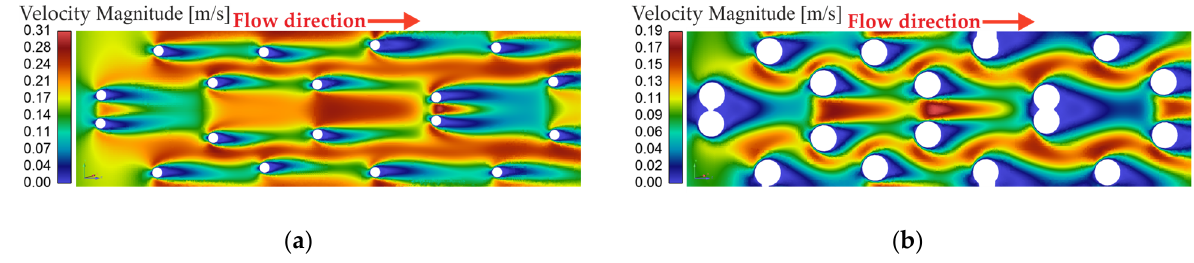
Figure 7. A cut plane of the velocity contours plots in middle cross section for steady flow at Re = 25. Unit is m/s. ( a ) ε = 0.954. ( b ) ε = 0.743.